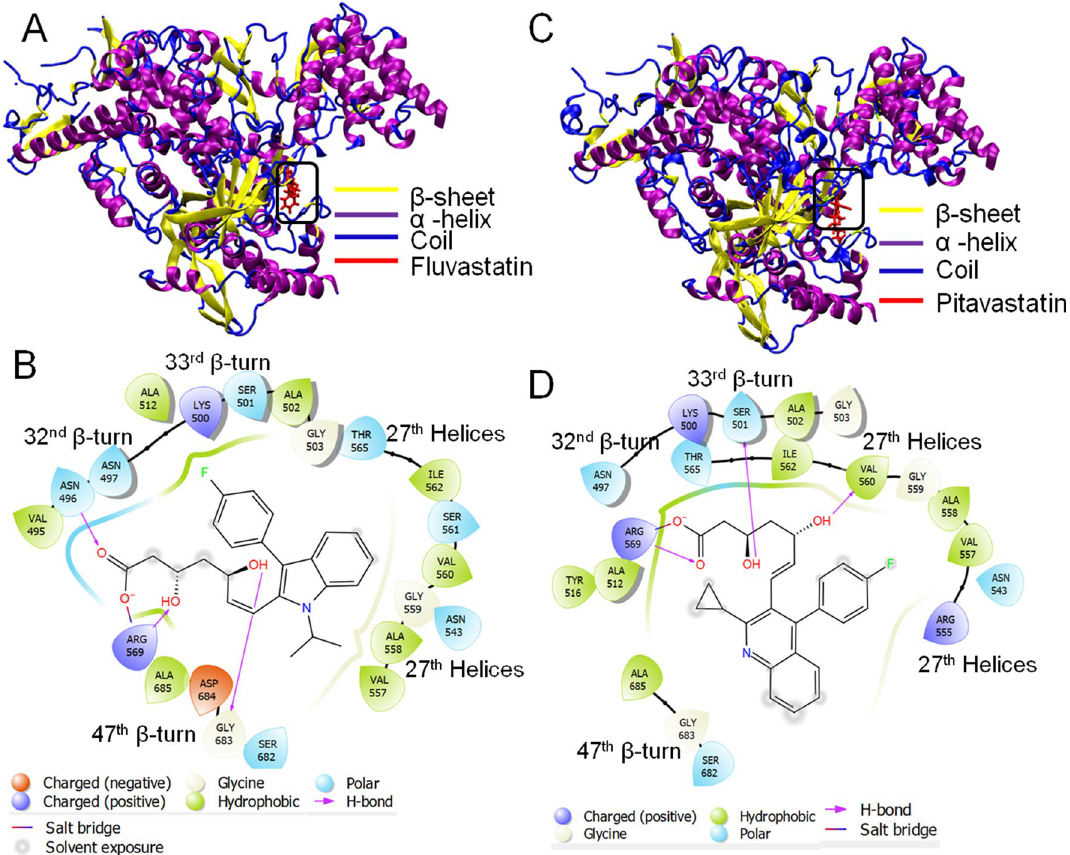
Figure 4. Molecular docking study of fluvastatin and pitavastatin to RdRp. (A,C) 3D diagram of fluvastatin- RdRp complex and pitavastatin-RdRp complex, respectively. (B,D) 2D diagram for representation of interactions of ligand molecule with the amino acid residues at the binding site; (B) fluvastatin-RdRp complex and (D) pitavastatin-RdRp complex. All 3D images were generated using the VMD (visual molecular dynamics) software (version 1.9.3) and 2D images were generated by the graphical user interface Maestro, Schrödinger (https:// www. schro dinger. com/ produ cts/ maest